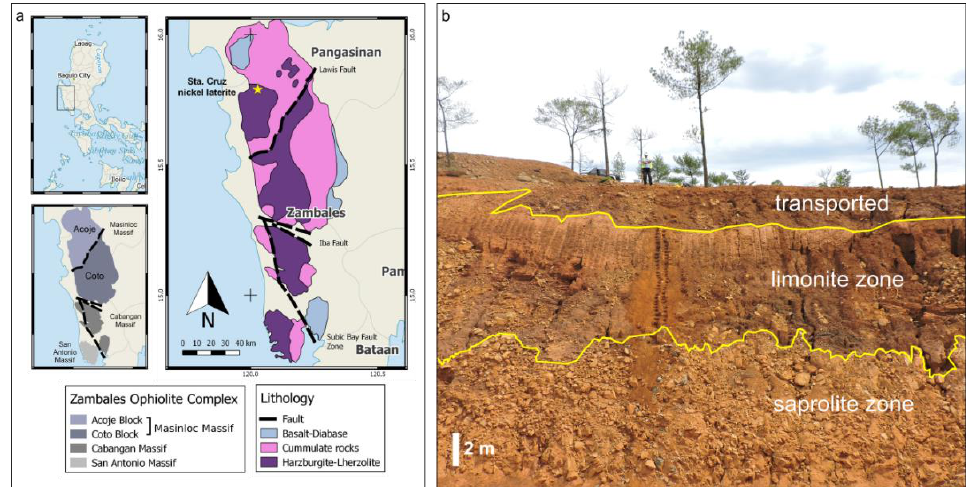
Figure 1. ( a ) Location of the study area. The Zambales Ophiolite Complex is in west Central Luzon, Philippines. It is subdivided into three massifs—the Masinloc, Cabangan, and San Antonio Massifs—separated by west–northwest fault boundaries. The Masinloc massif is subdivided into the Acoje and Coto blocks. Yellow star indicates the location of the Sta. Cruz nickel laterite deposit. ( b ) Photo of the nickel laterite profile investigated. The saprolite zone is overlain by the limonite zone. The topmost unit is a mechanically transported layer and is therefore not sampled for this study. Modified from Aquino et al. [34].